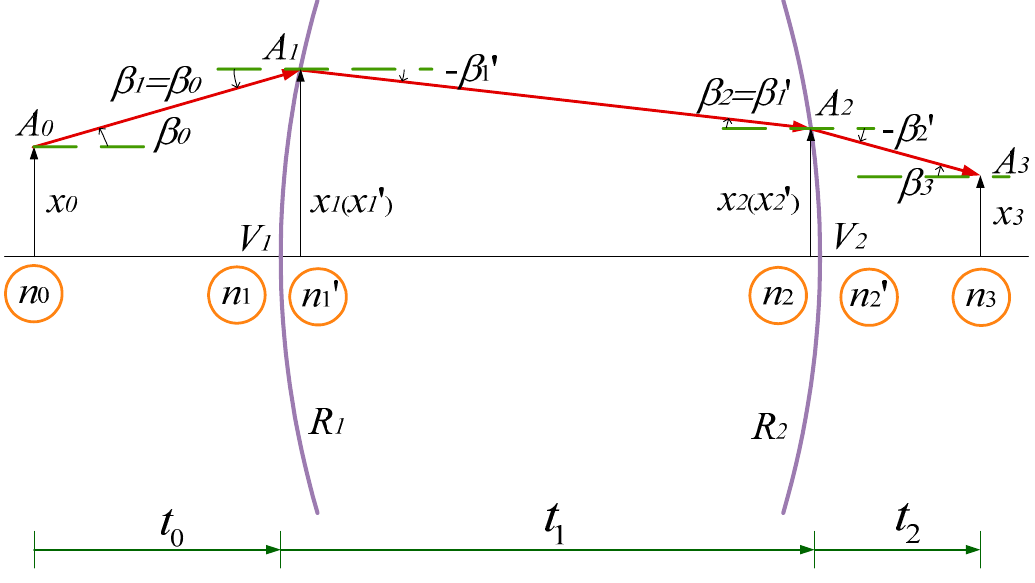
Figure 6. Propagation path diagram of light in single lens. A 0 through the optical system consisting of two A 3 can be described by Equation (11).